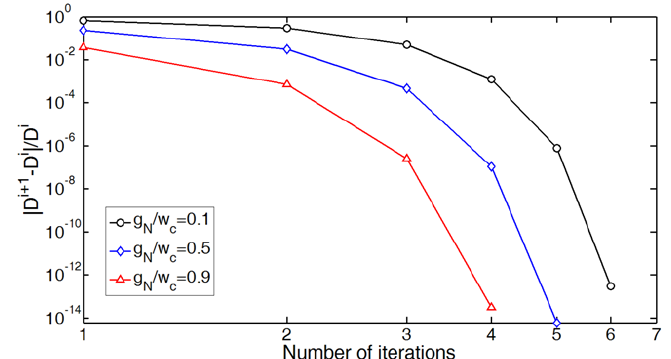
Figure 4: Quadratic convergence of the Newton-Raphson method used for the computation of the cohesive tractions, for three different values